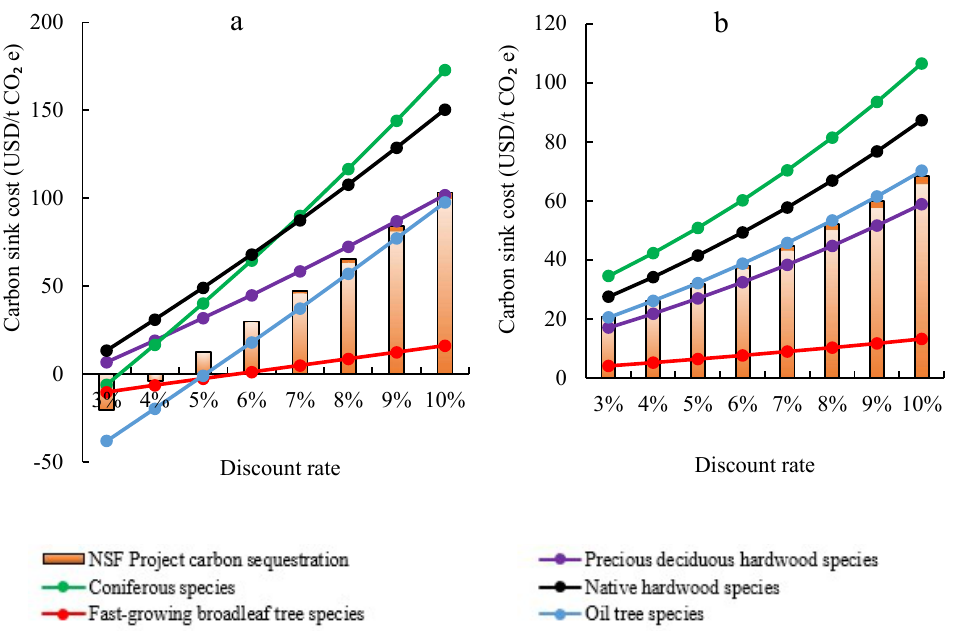
Figure 7. Carbon sink cost dynamic with discount rate change under DI ( a ) and PPP ( b ) investment mode in Laohekou NAP.